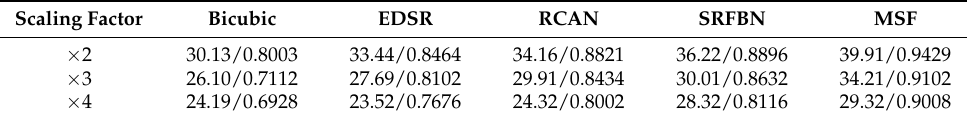
Table 2. The average PSNR/SSIM results on dataset with different scaling